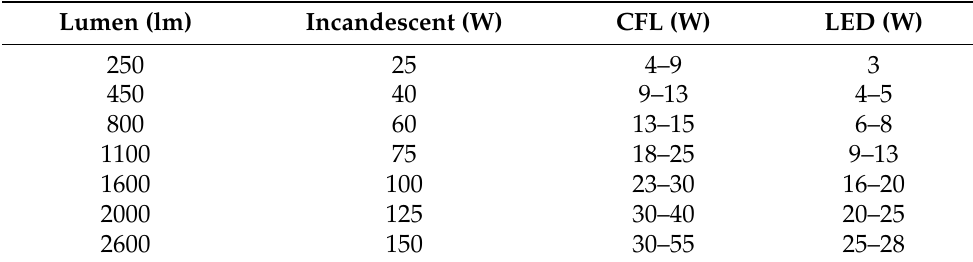
Table 1. Comparison of the produced lumens and the power consumption from different light bulb technologies.